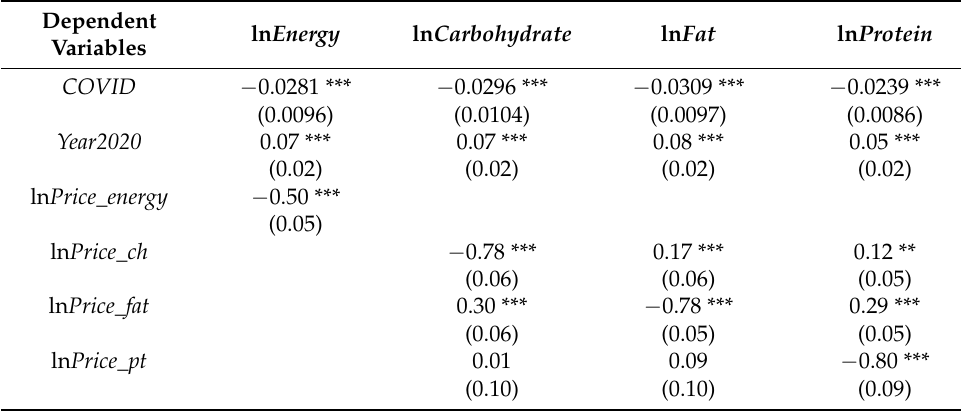
Table A2. Estimation results from the instrumental fixed effect